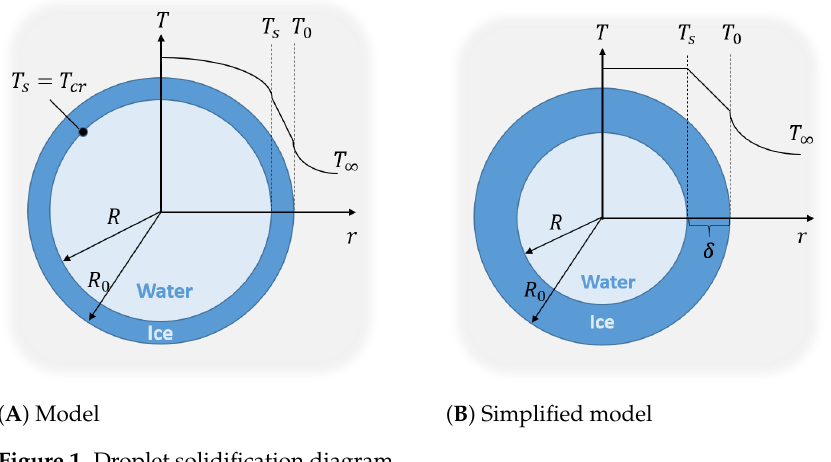
Figure 1. Droplet solidification